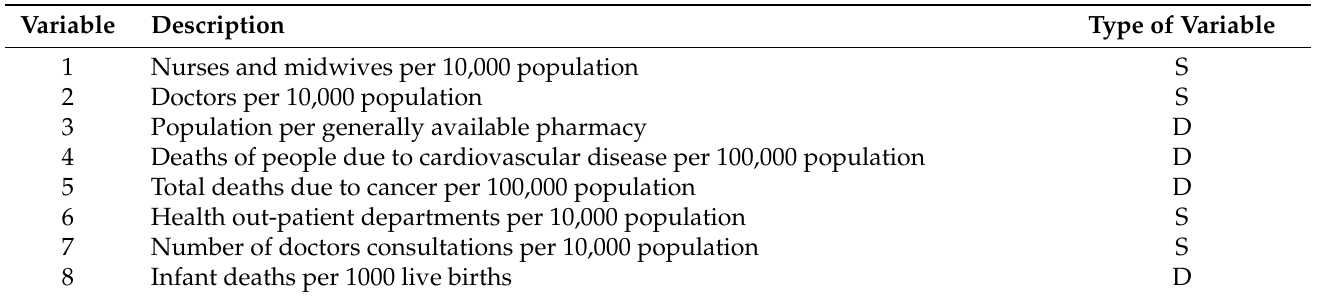
Table 1. List of variables used in analysis.